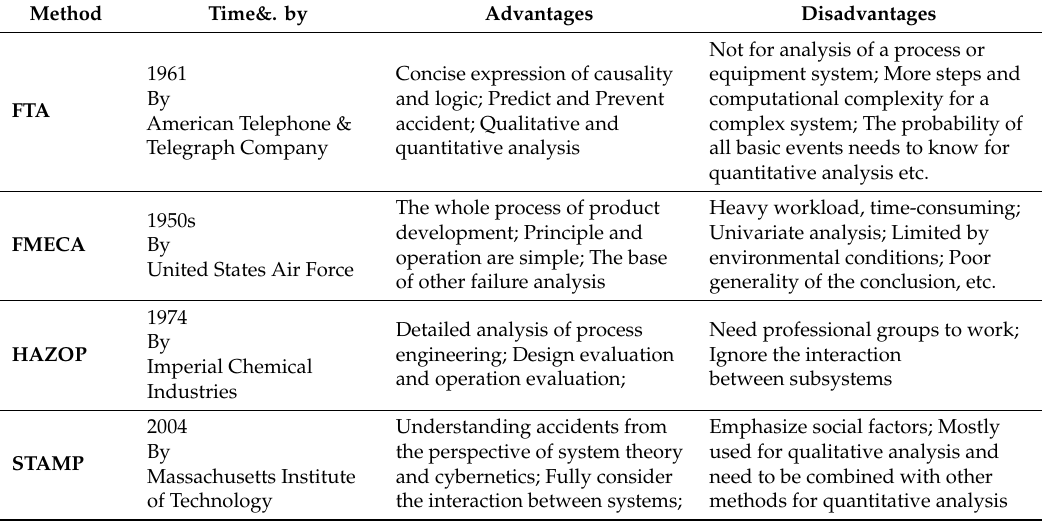
Table 2. Comparison of safety analysis